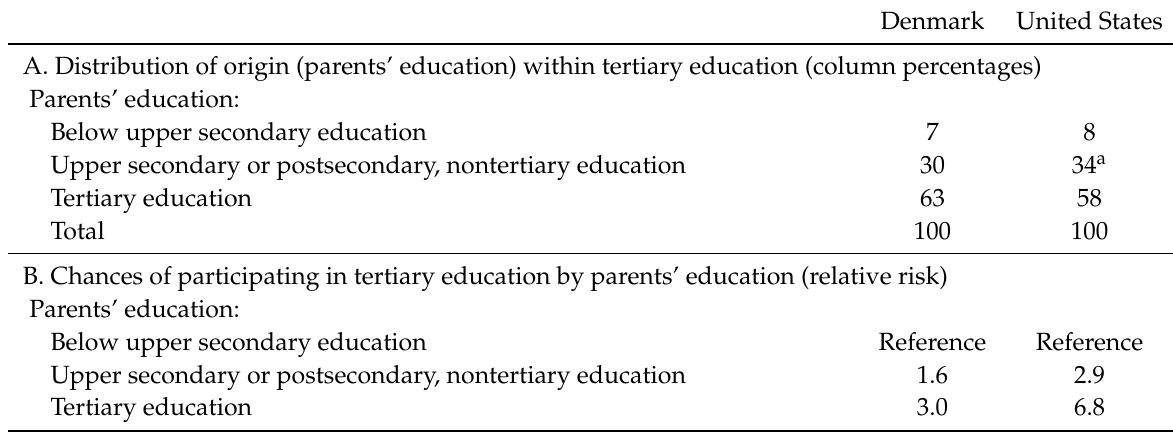
Table 1: Participation of 20- to 34-year-olds in tertiary education by parents’ education in Denmark and the United